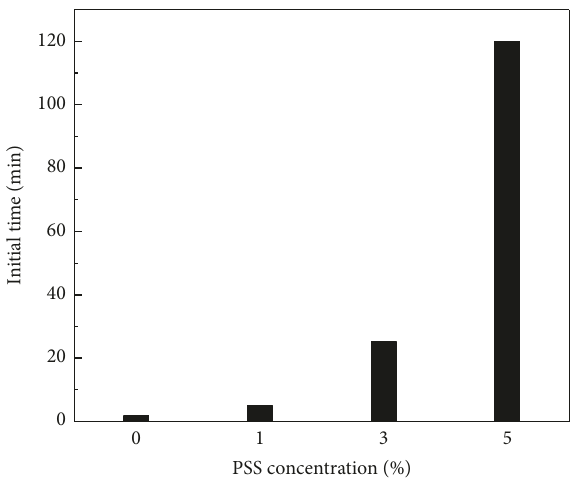
Figure 12: Initial time of running water from outlet number 9 of specimens with different PSS